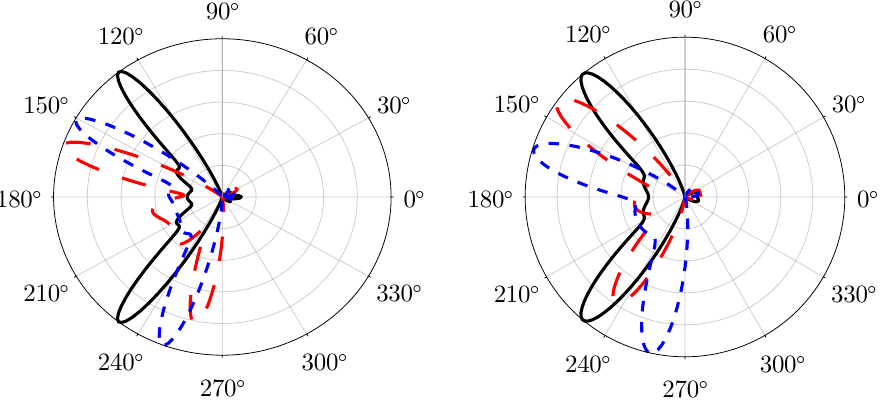
Figure 6. Photoelectron angular distributions in the polarization plane ( ϑ p = π /2) for a krypton target. Angular distributions are shown for elliptically-polarized laser beams with (cid:101) = 0.36 ( left 2.9 ω according to the third ATI panel ) and (cid:101) = 0.56 ( right panel ) at fixed photoelectron energy ε p ≈ peak in Figure 5. Different approximations are compared for these angular distributions: a hydrogenic 1 s initial orbital together with a plane-wave Volkov continuum (black-solid curves); a self-consistent initial 4 p orbital of neutral krypton together with a Coulomb–Volkov continuum (red long-dashed curves); the same initial 4 p orbital but together with a distorted-Volkov continuum (blue-dashed curves). All distributions are normalized on their maximum, while all other laser parameters are the same as in Figure